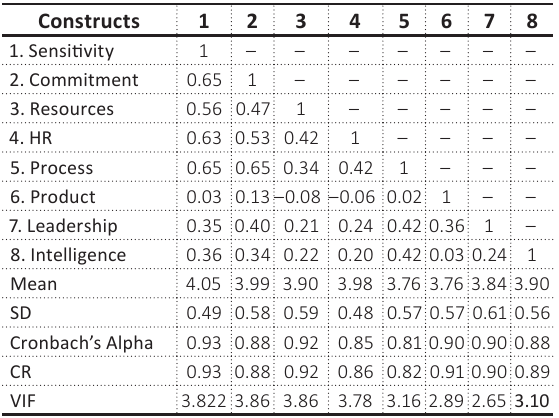
Results presented in Table 1 indicated probabili-